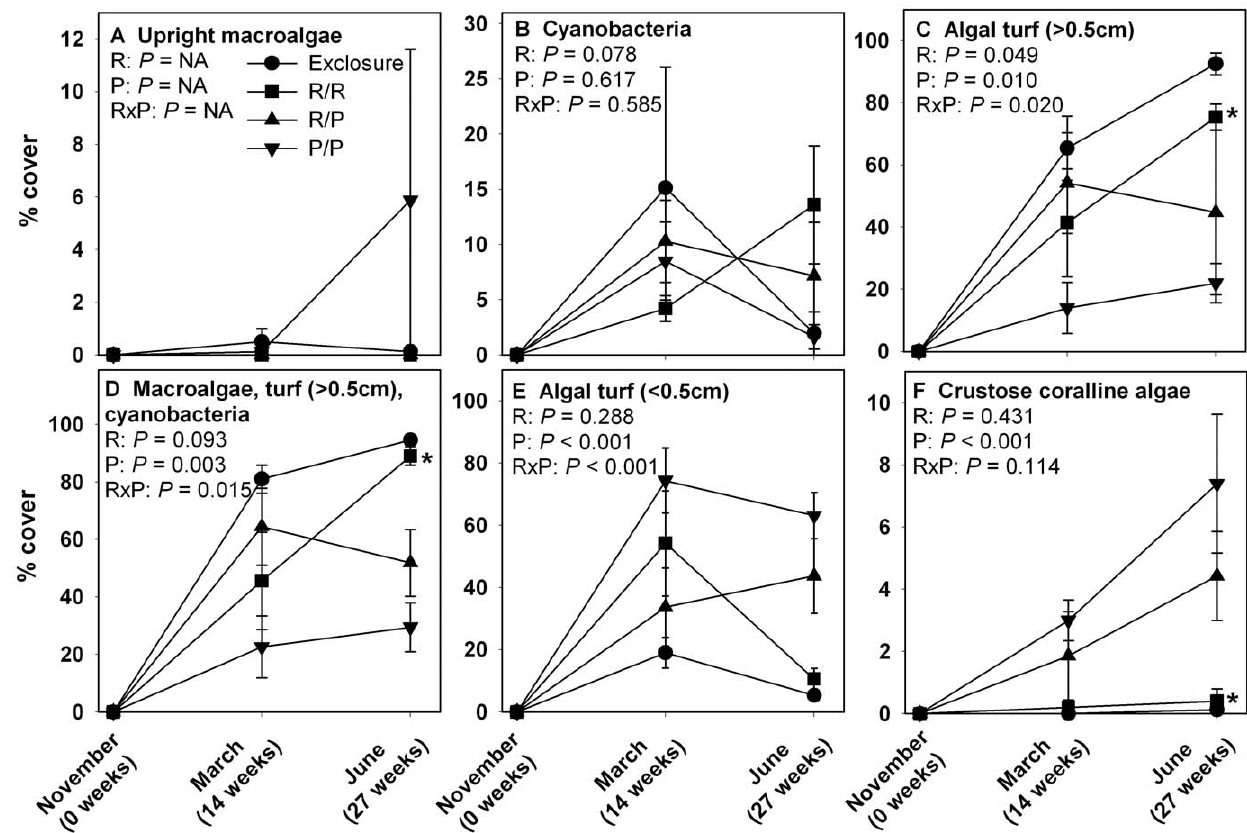
Figure 4. Percent cover (mean 6 SE) of common algal types over time during Year 2. R = redband parrotfish and P = princess parrotfish. Statistics as in Fig. 1, except the general absence of upright macroalgae prevented meaningful statistical analysis for Fig. 4A. n =8 for Exclosure, n =8 for P/P, n =7 for P/R, and n =5 for R/R.